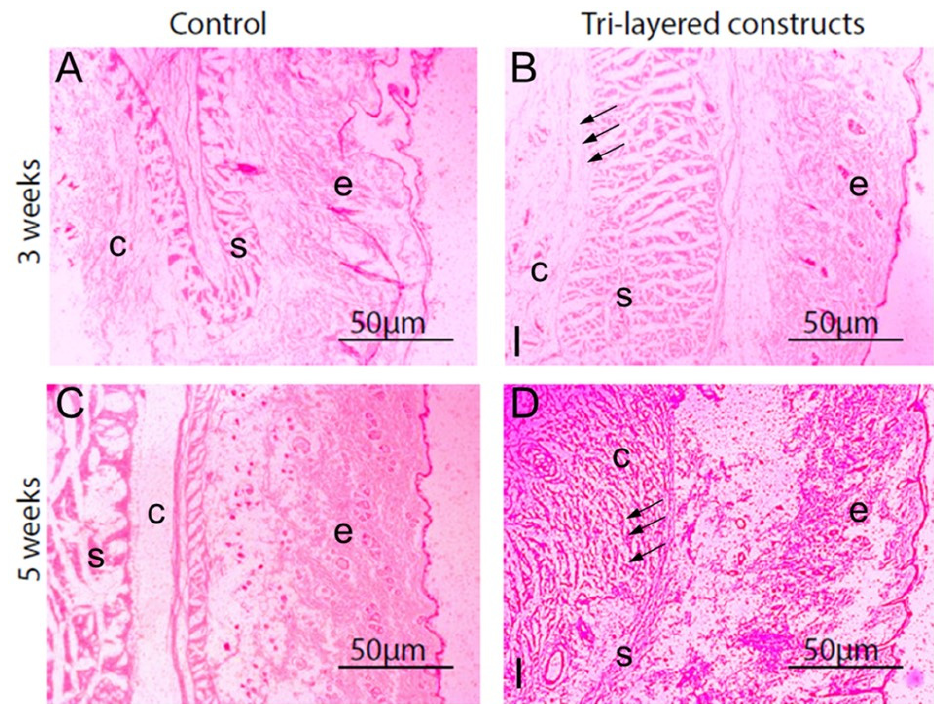
Figure 14. Histological images showing host inflammatory responses in subcutaneous tissue adjacent to functionally graded tri-layered membranes; ( A ) Tissue after three weeks of implantation with functionally graded membranes; ( B ) Peri-implant tissue (black arrows) indicates connective tissue without accumulation of inflammatory cells. Tissue without implants; ( C ) Peri-implant tissue after five weeks of implantation with functionally graded membranes; ( D ) Site of implantation indicates fibrous tissue (black arrows). Abbreviations: I, tissue near functionally graded chitosan membranes; c, connective tissue; e, epidermis; s, skeletal muscles [234].